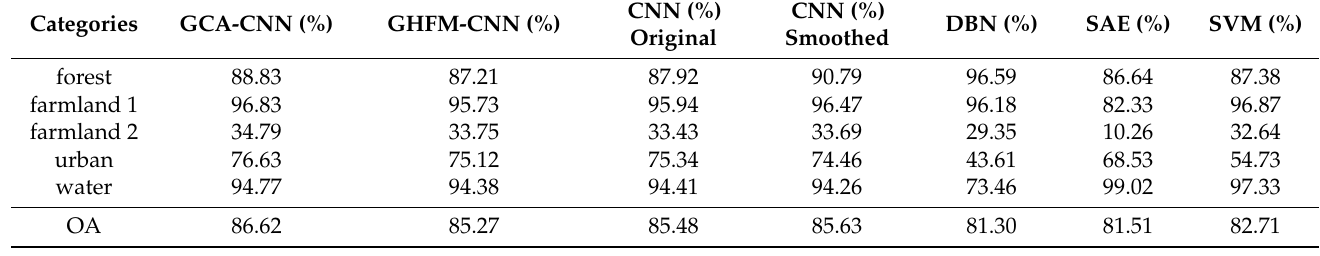
Figure 13. The converging curve of GCA-CNN on the Flevoland image.